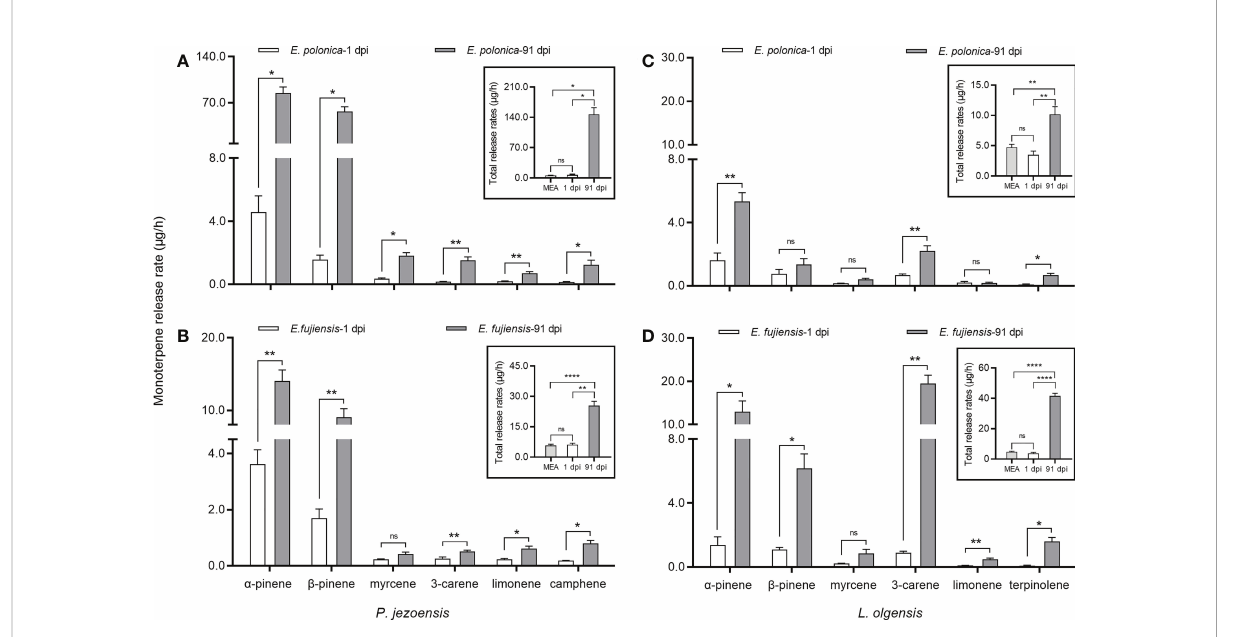
FIGURE 3 Mean ( ± SE) release rates ( m g/h) of monoterpenes of P. jezoensis and L. olgensis in response to culture inoculations. (A, C) P . jezoensis and L. olgensis inoculated with E. polonica and MEA, respectively; (B, D) P . jezoensis and L. olgensis inoculated with fujiensis and MEA, respectively. Insets show total monoterpene release ( m g/h) for each treatment. Asterisks indicate signi fi cant differences (* p < 0.05, ** p < 0.01, **** p < 0.0001) and ns indicates no signi fi cant differences (T-test for independent samples, a =0.05; n =3 tree replicates per